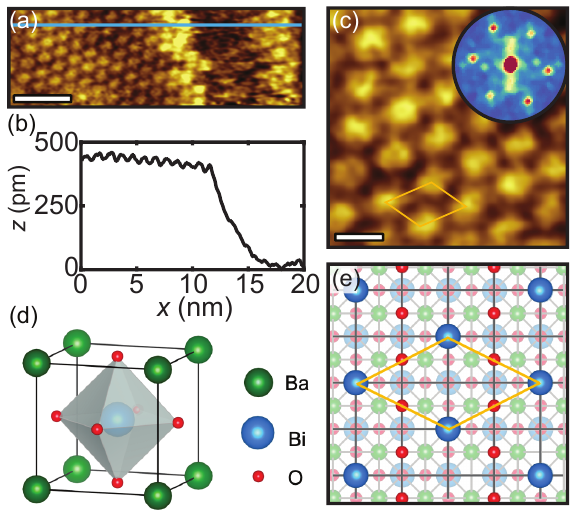
Figure 1. ( a ) Topography image (20 × 7 nm, scale bar is 4 nm) of the 10-unit-cell-thick BaBiO 3 (BBO) film on Nb:STO showing a stepped surface. ( b ) Cross-sectional height profile along the corresponding light blue line segment in ( a ). The step height is approximately 4.5 Å. ( c ) Zoomed image (5 × 5 nm, scale bar 1 nm) showing the c(4 × 2) surface reconstruction, the diamond-shaped orange lines indicate the unit cell. Inset: The corresponding Fast Fourier transform (FFT) showing a threefold symmetry with a periodicity of 1 nm. ( d ) Schematic of the cubic perovskite BBO unit cell. The gray-shaded area represents an oxygen octaheder. ( e ) A top view of the c(4 × 2) surface reconstruction. The diamond-shaped orange lines show the unit cell (corresponding to the orange diamond shape in ( c